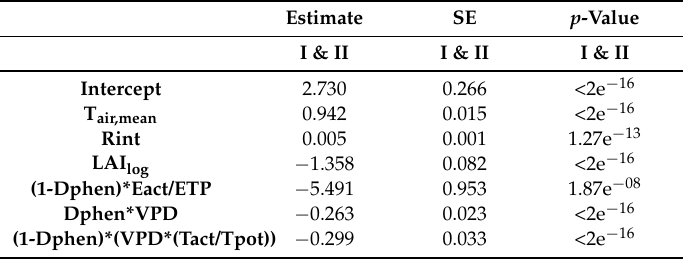
Table 2. Statistics of the multiple linear regression model developed using a forward stepwise-based selection procedure and quantile regression analyses for predicting T c,mean (T c,mean = mean